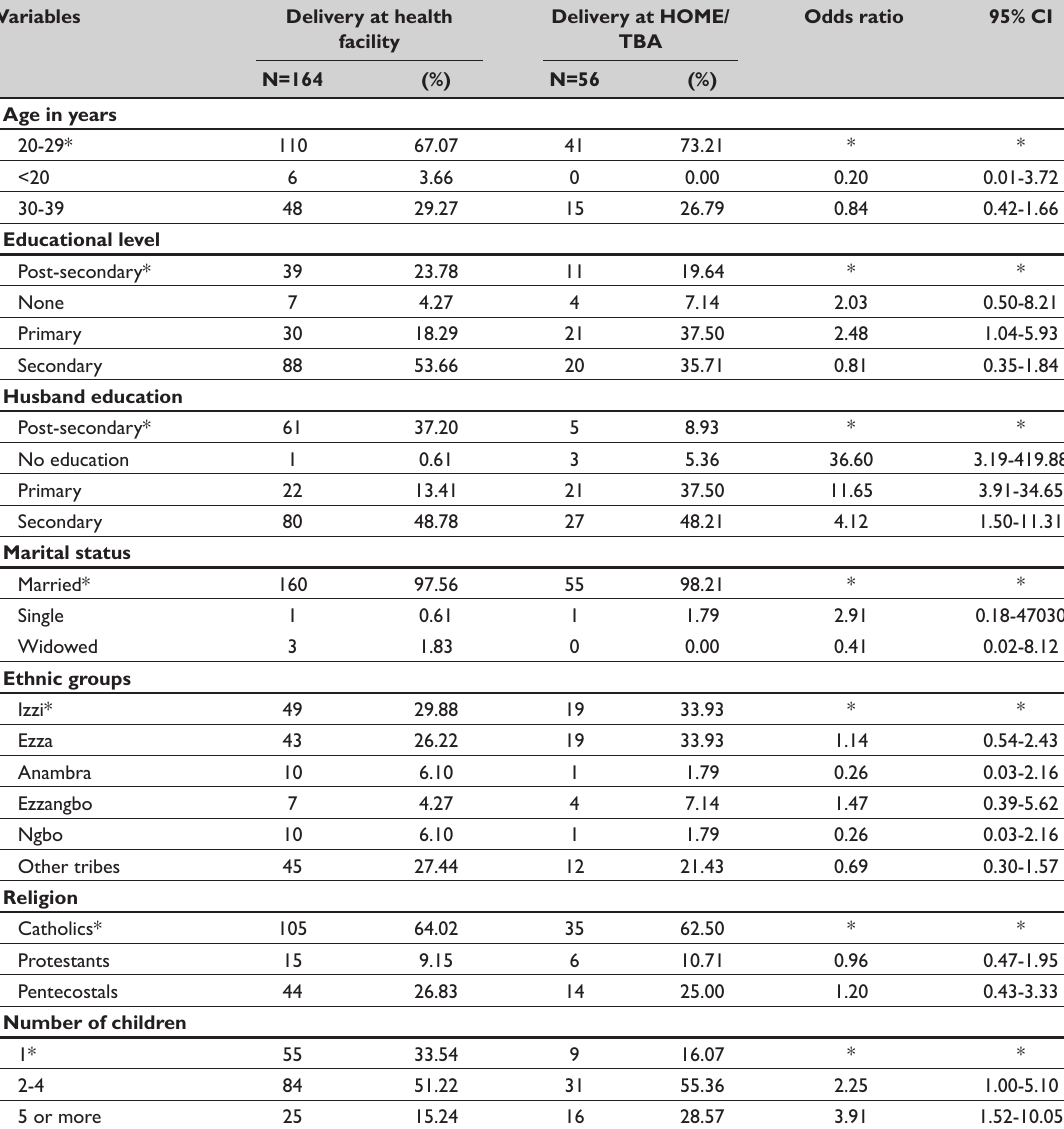
Table 1: Demographic characteristics of study participants and influence of demographic characteristics on choice of health facility